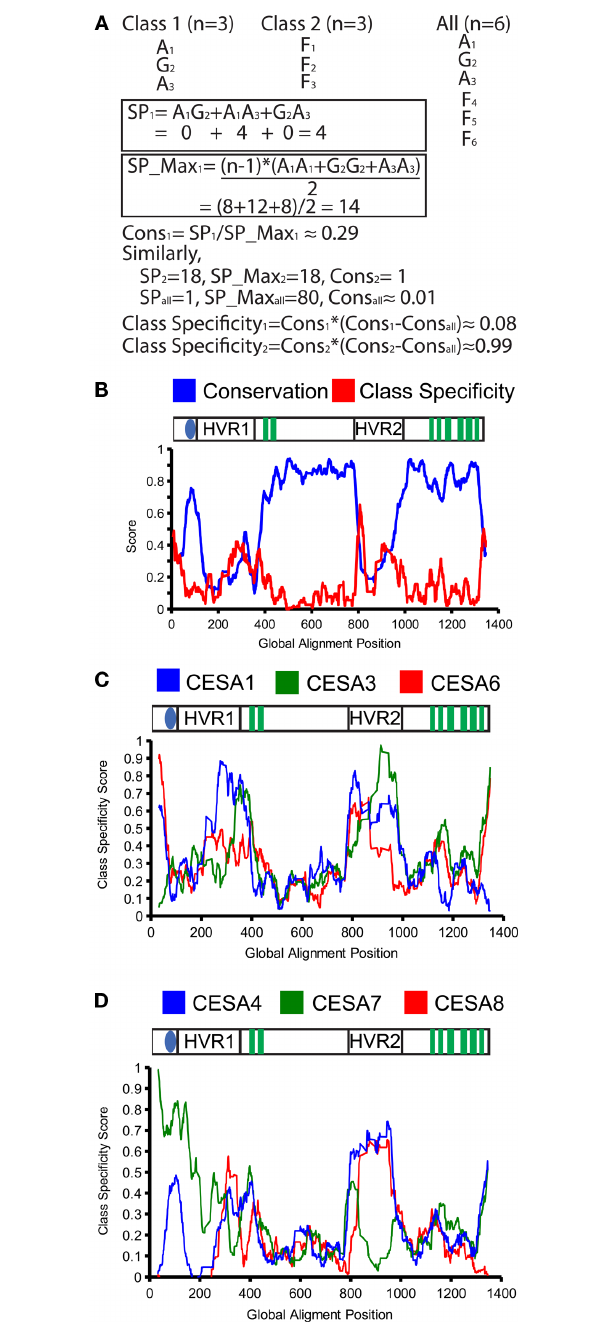
FiGuRe 2 | Conservation and class-specificity in the cellulose synthase family. An example calculation of conservation (Cons) and class specificity using the sum-of-pairs (SP) and max-sum-of-pairs (SP_max). SP and SP_Max are determined from the BLOSUM62 matrix (A) . The conservation and class specificity averaged for all CesA genes with a sliding window of 10 amino acids is plotted. The x -axis represents the position in the global alignment. The cartoon above the graph plots the major CesA features against alignment positions. Transmembrane domains are represented as green boxes, the zinc finger as the blue oval, and both hypervariable regions are listed (HVR) (B) . The class specificity for each CesA family is plotted for the primary CesAs (C) and secondary CesAs